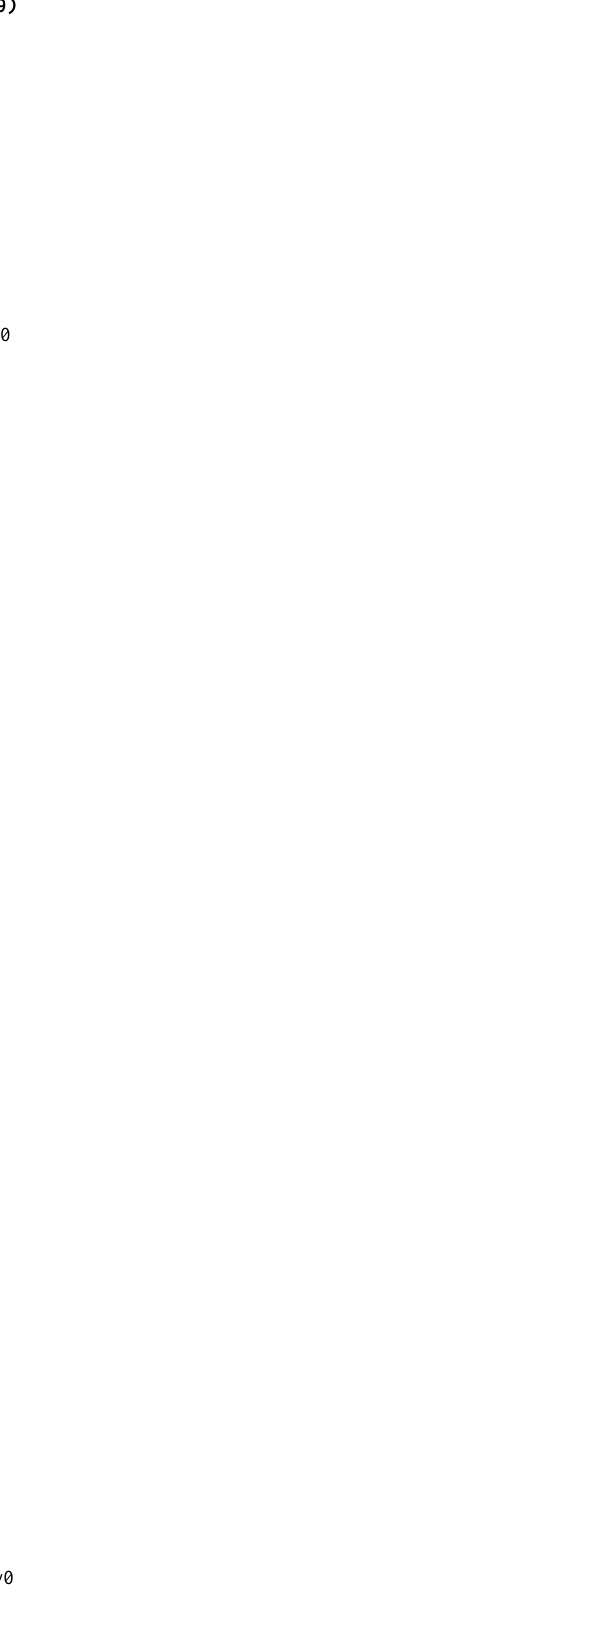
Diagnosis and treatment of the coronavirus disease